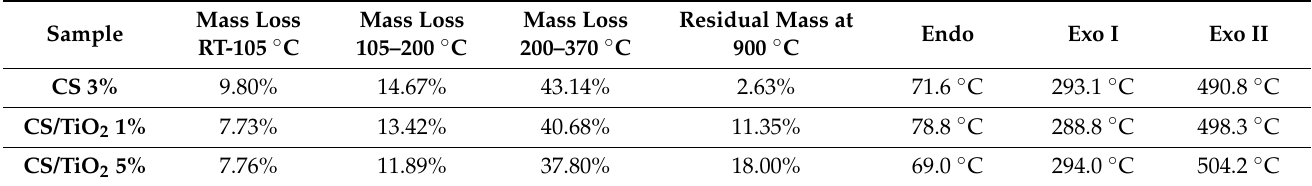
Figure 5. TG-DSC curves of chitosan and chitosan/TiO 2 composite membranes. Table 2. Information regarding the TG/DSC analysis of chitosan/TiO 2 composite